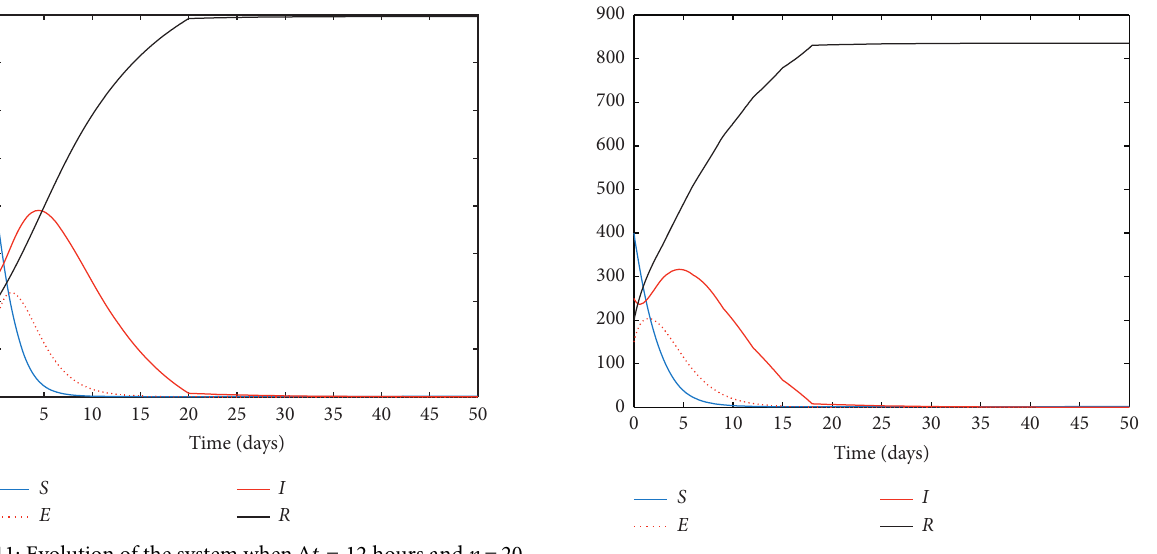
Figure 13: Evolution of the system when Δ t � 72 hours and n � 20 days.